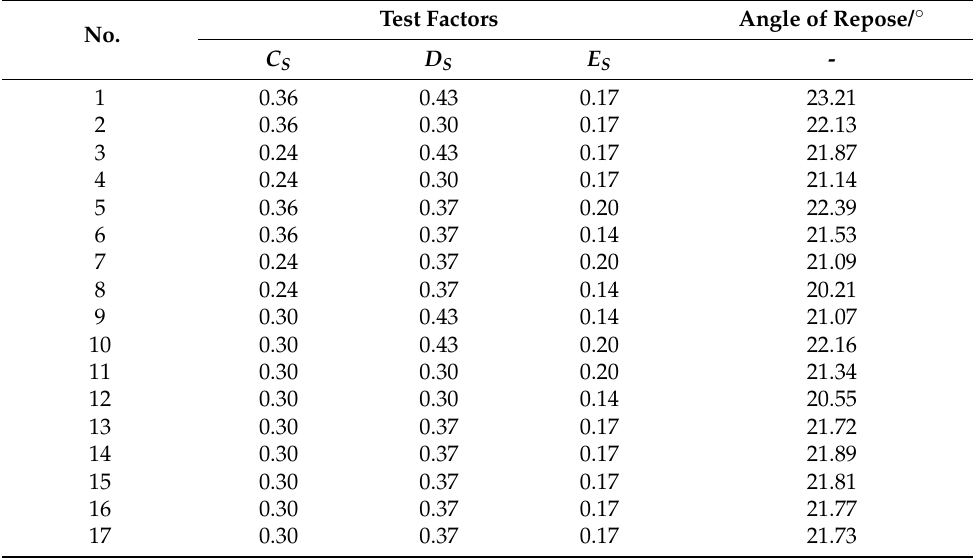
Table 9. Box–Behnken experiment design scheme and results. Test Factors Angle of Repose/ ◦ No. C